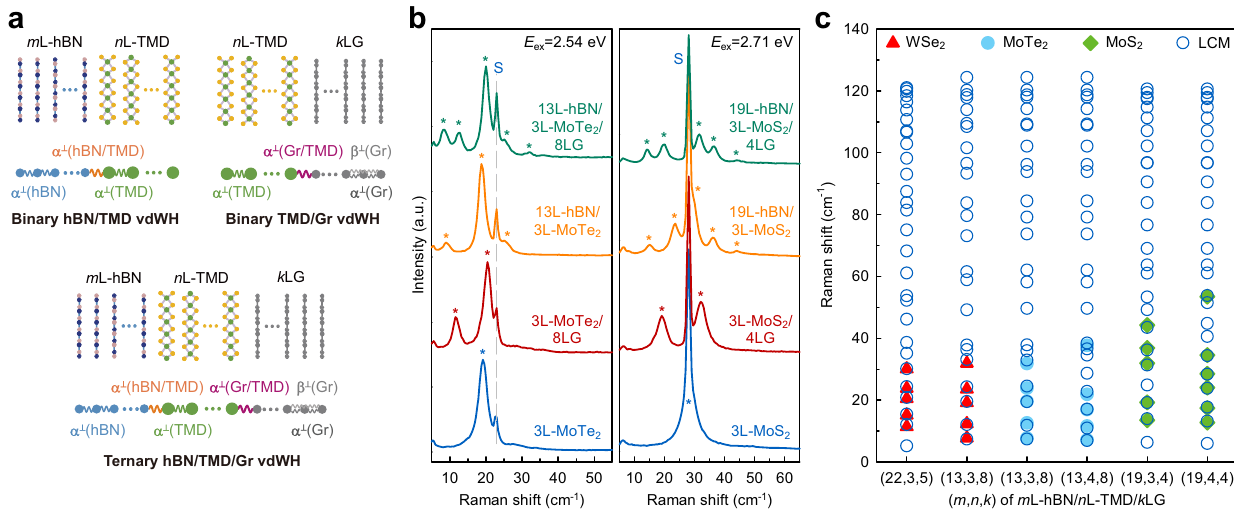
Fig. 3 LB modes in binary and ternary TMD-based vdWHs. a Schematic diagram of LCM for hBN/TMD, TMD/Gr, and hBN/TMD/Gr vdWHs. b LF Raman spectra of 13L-hBN/3L-MoTe 2 /8LG, 19L-hBN/3L-MoS 2 /4LG, and their corresponding binary hBN/TMD, TMD/Gr vdWHs and individual TMD fl akes. c Calculated (hollow circles) and experimental ( fi lled symbols) Pos(LB) in m L-hBN/ n L-TMD/ k LG vdWHs (TMD = WSe 2 , MoTe 2 , and MoSe 2 ). Indexes ( m , n , k ) represent the number of layers of the constituents in each c = 3.0 × 10 8 m ⋅ s − 1 is the speed of light. D is the LB force constant Note that the second nearest-neighbor LB force constants are not matrix, in which element D ij ( i ≠ j ) is the negative value of the LB applicable for 2L-A and 2L-B. P D ij . Take force constant between i th and j th layers and D ii ¼ (cid:2) Usually, based on the previous reports, the nearest-neighbor LB j 3L-A/3L-B as an example, M can be written as coupling is enough to reproduce Pos(LB) in TMD, hBN and the related vdWHs 19,35,36 . However, the second nearest-neighbor LB force constant should be taken into account for multilayer graphene fl akes 12,18 . Figure 3a depicts the schematic diagrams of LCM for hBN/ TMD, TMD/Gr binary vdWHs, and hBN/TMD/Gr ternary vdWHs along with their corresponding LB force constants, i.e., α ⊥ (TMD), α ⊥ (hBN), α ⊥ (Gr), β ⊥ (Gr), α ⊥ (hBN/TMD), and α ⊥ (Gr/TMD). Generally, α ⊥ (TMD) can be directly obtained from Pos(LB) in TMD fl akes, whose LB modes are easily observed at E ex matching to the C exciton energy. In contrast, the LB modes are unobservable in graphene and hBN fl akes due to